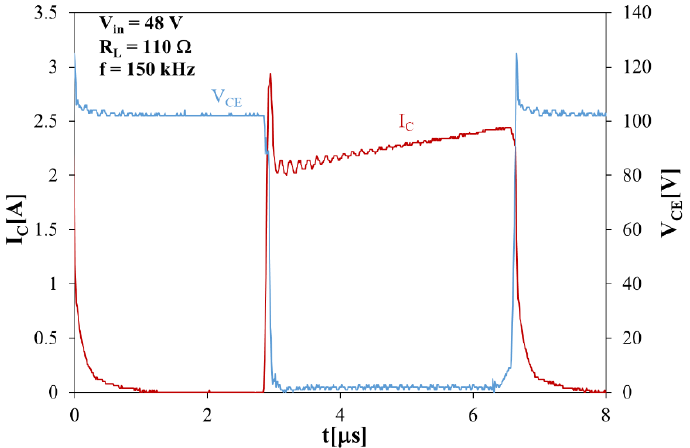
Figure 12. Measured waveforms of the collector–emitter voltage (blue solid line) and the collector current (red solid line) of the IGBT in the investigated boost converter.